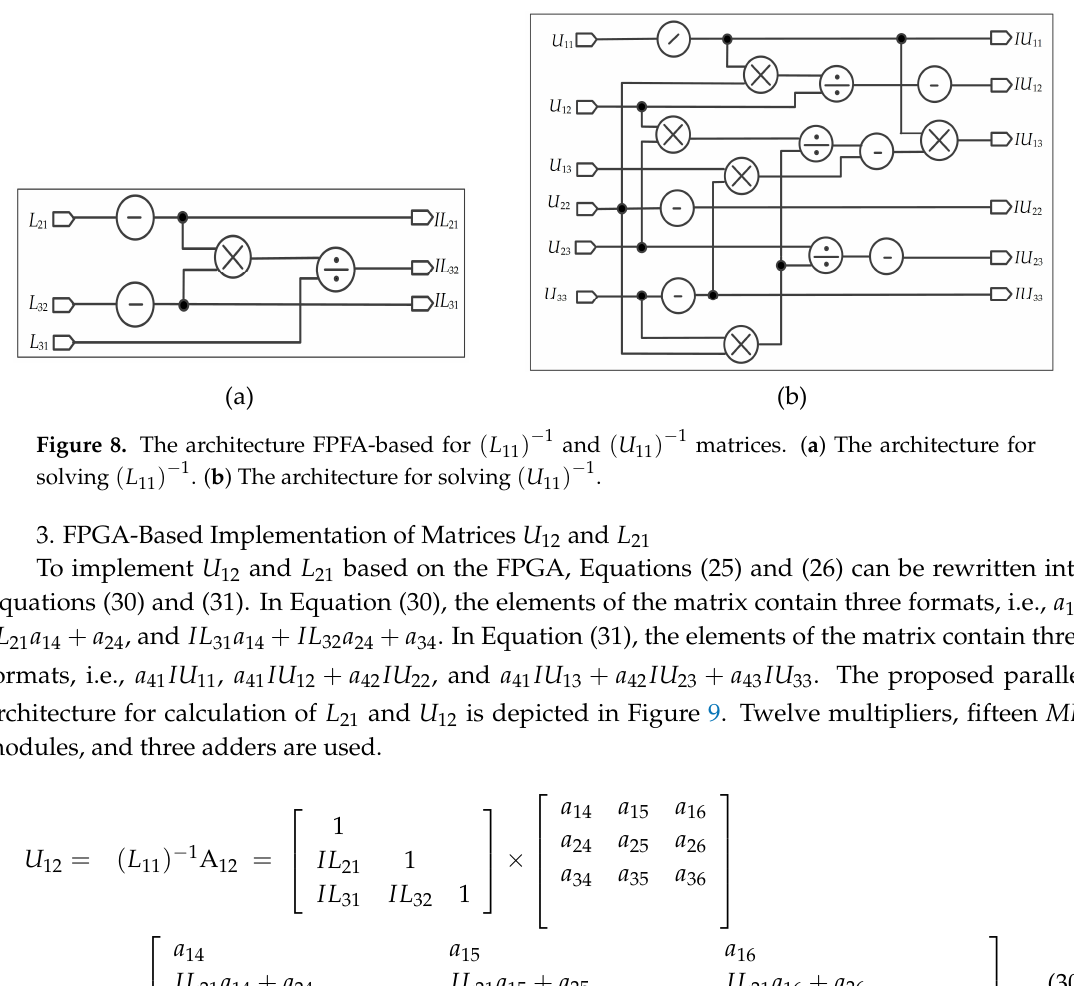
11 of 28 Figure 7. Parallel computation block lower-upper (LU) decomposition of 11 A . 2. FPGA-Based Parallel Computation for Matrices